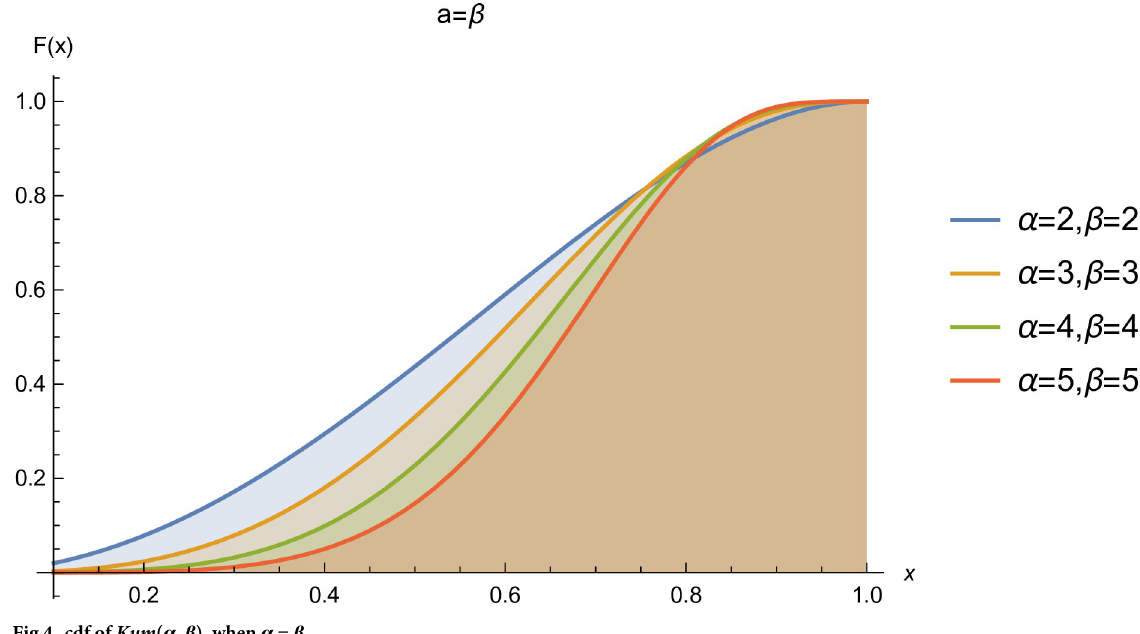
Fig 4. cdf of Kum ( α , β ), when α = β .